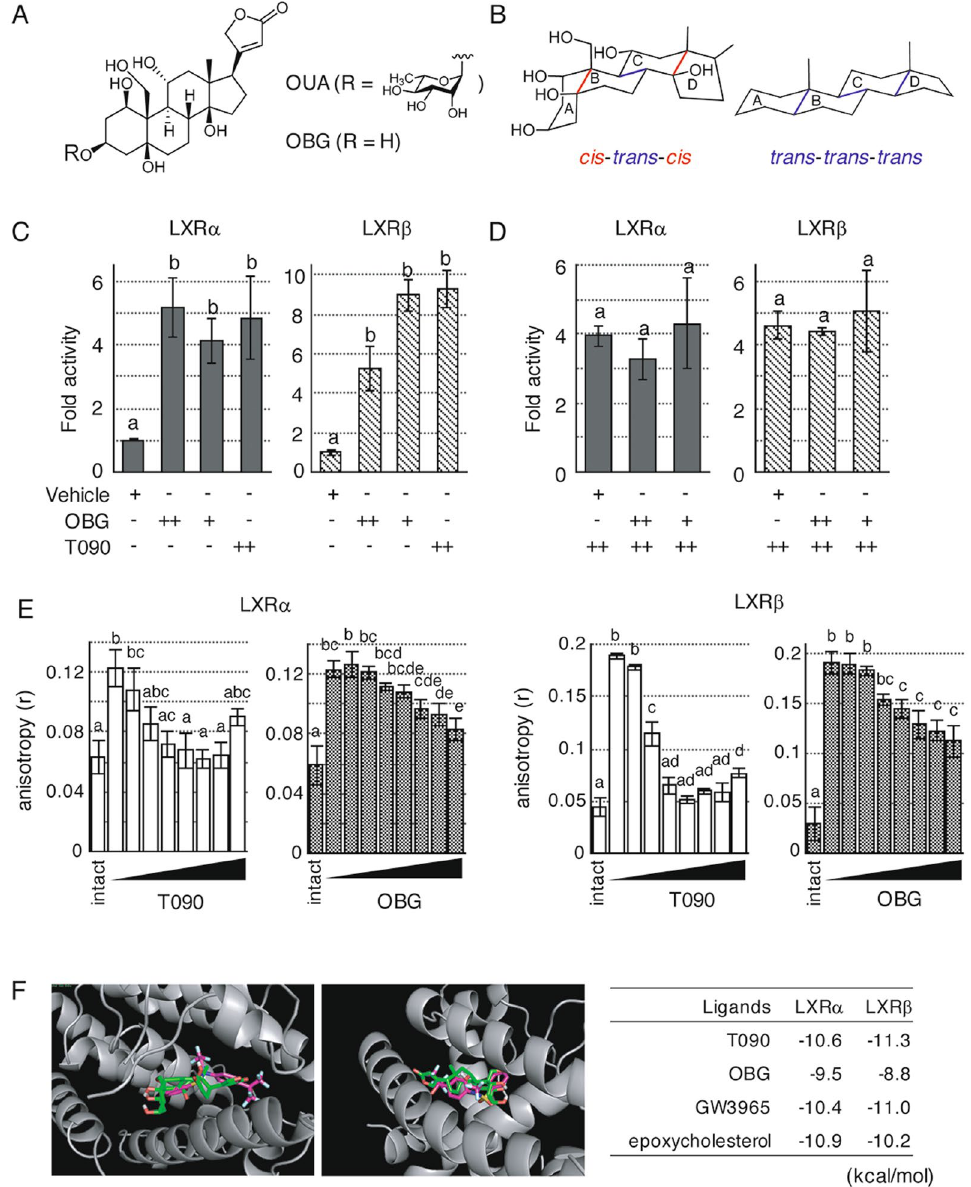
Figure 1. Identification of OBG as a ligand for LXRs. ( A ) Chemical structure of OBG and ouabain (OUA). ( B ) OBG has a unique steroidal ring fusion skeleton. OBG is built around a cis - trans - cis -fused A/B/C/D-ring system (left panel), whereas most normal steroid hormones have an all - trans -fused ring system (right panel). ( C and D ) OBG displays agonistic activity towards LXRs in luciferase reporter assays. 293 T cells transfected with LXRs/RXR, the DR4-tk-Luc reporter and the Renilla reporter plasmid (as a control) were subjected to luciferase assays at 48 h after treatment with 10 − 8 M or 10 − 9 M OBG and/or 10 − 9 M T0901317. The fold change in transcriptional activity is expressed as the mean ± SD of triplicate experiments. Values followed by different letters are statistically different according to analysis of variance (ANOVA) followed by SNK tests (P < 0.01). ( E ) Competitive binding assay using the fluorescent LXR ligand by detection of fluorescent anisotropy. To the solution of complex of LXR-LBD (0.5 μ M) and the fluorescent LXR ligand (0.5 μ M), OBG or T0901317 was added with the concentration of 0 μ M, 0.1 μ M, the buffer without protein. Bar graphs represent means ± SD of dependent three experiments and values followed by different letters are statistically different according to ANOVA followed by SNK tests (P < 0.01). ( F ) OBG has a strong affinity for LXRs in in silico docking simulations. Using previously reported datasets from crystal structures of the LXR/T0901317 complex, OBG was subjected to in silico docking simulations and the results were compared with other known LXR ligands. After docking simulation, both superimposed structures between OBG (green colored structure) and T0901317 (magenta colored structure) were settled down around the similar pocket of LXR α (gray colored ribbon in left panel) and LXR β (gray colored ribbon in right panel). Based on the simulations, the stabilisation energy was calculated (right table). T0901317 and GW3965 are synthetic ligands of LXRs, and 24( S ), 25-epoxycholesterol is a natural